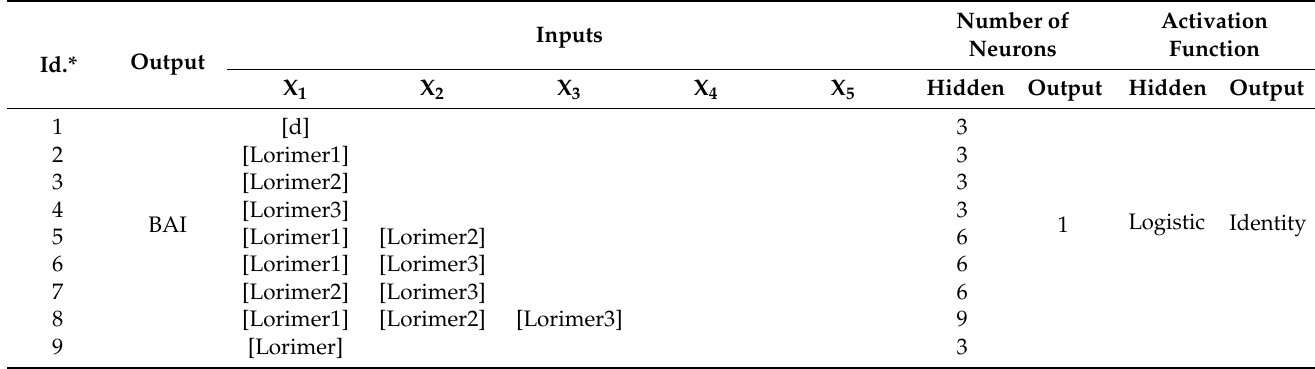
Table 3. Configuration of artificial neural networks to describe the BAI of the A. angustifolia in mixed ombrophilous forest in Southern